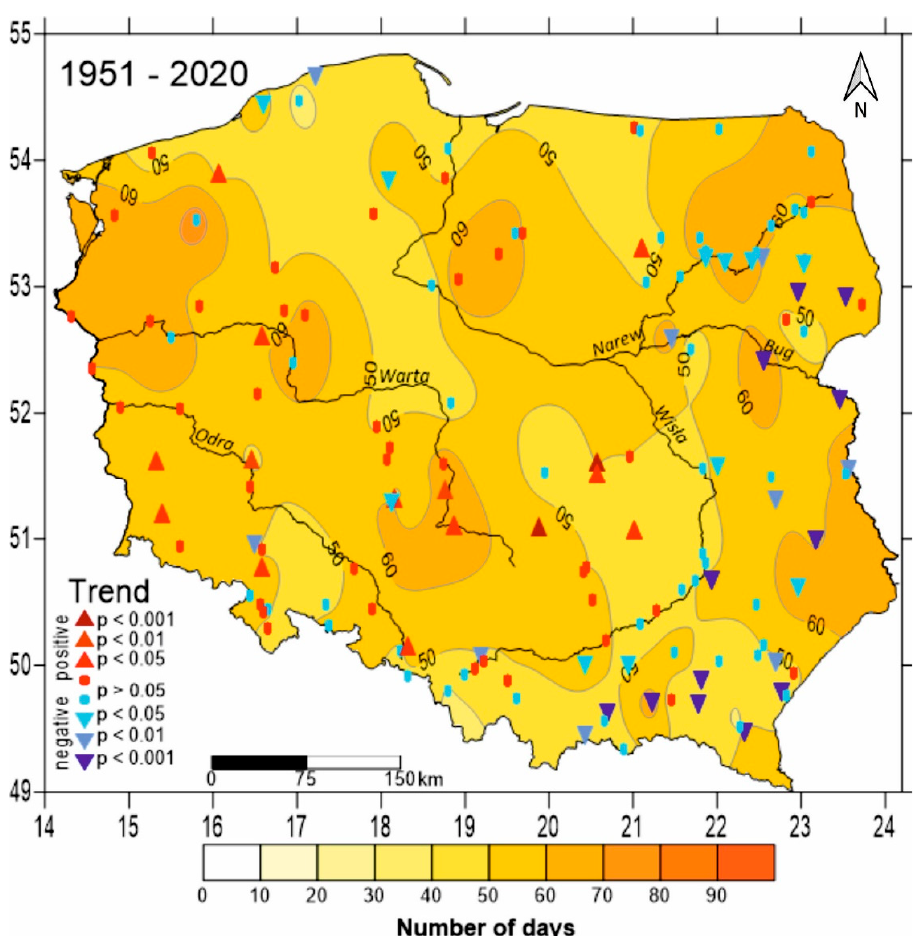
Figure 11. Spatial distribution of ND LF and the trends of changes in 1951–2020 with their statistical significance ( p ).